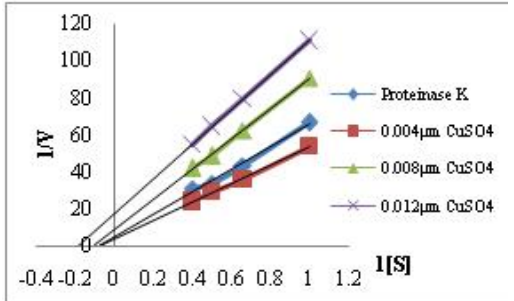
Fig. 5 . Lineweaver-Burk plot of proteinase K at various Cu 2+ centrations at 313 K, pH=7.4 Table 4 . Kinetic parameter of V various Cu 2+ concentrations at 313